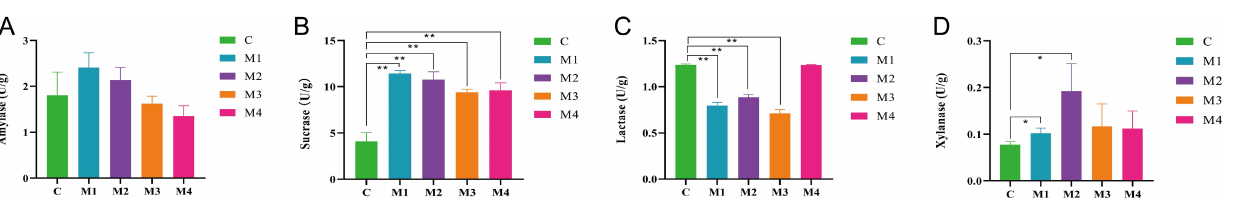
Figure 5. Effects of adenine combined with Folium sennae modeling on the intestinal contents enzyme activities of diarrhea mice. (a) Amylase activity. (b) Sucrase activity. (c) Lactase activity. (d) Xylanase activity. Data were expressed as mean ± standard deviation, n = 6, * P < .05, ** P <